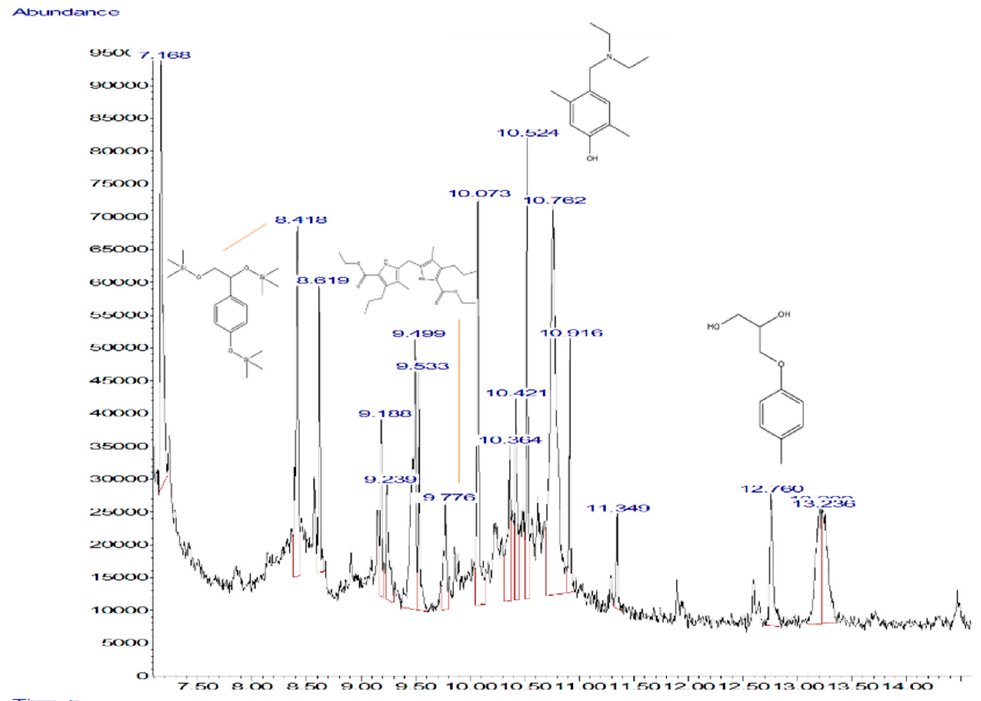
Appl. Sci. 2019 , 9 , x FOR PEER REVIEW Figure A3. GC-MS chromatogram from MAW–pistachio hull. Figure A3. GC-MS chromatogram from MAW–pistachio hull.